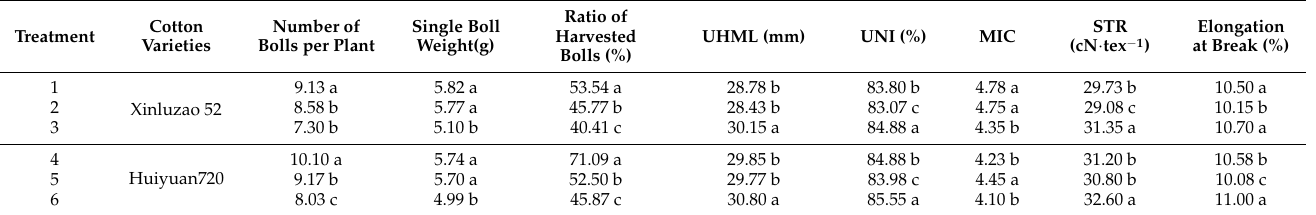
Table 5. Effects of chemical topping agent sprayed by two sprayers on the cotton yield and fiber